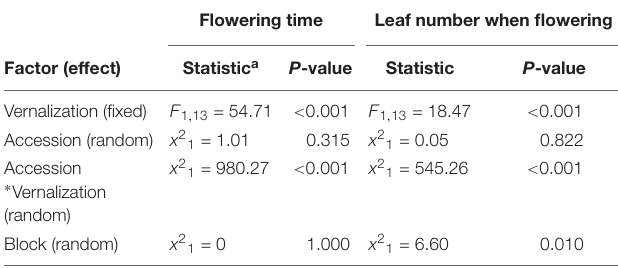
TABLE 1 | Analysis of variance of phenology in the Moonrise Ridge population. Flowering time